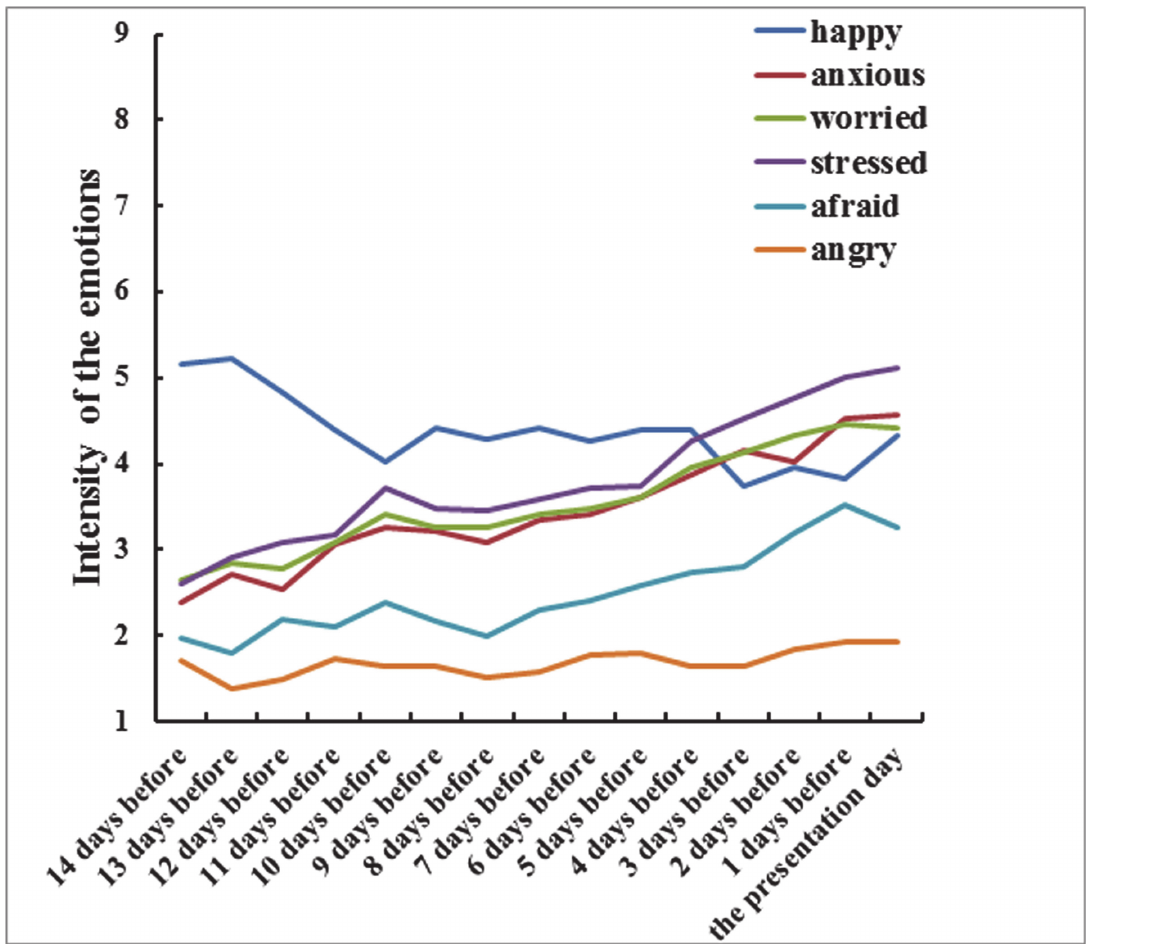
Fig 2. The time course of 6 anticipated emotions before the presentation in Study